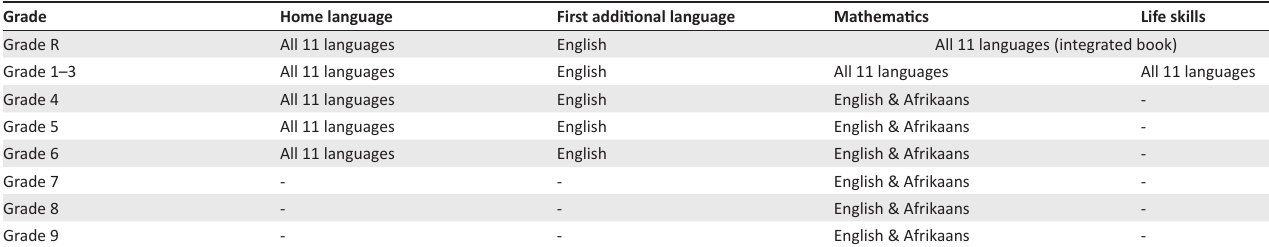
TABLE 1: Workbook subjects and language per grade